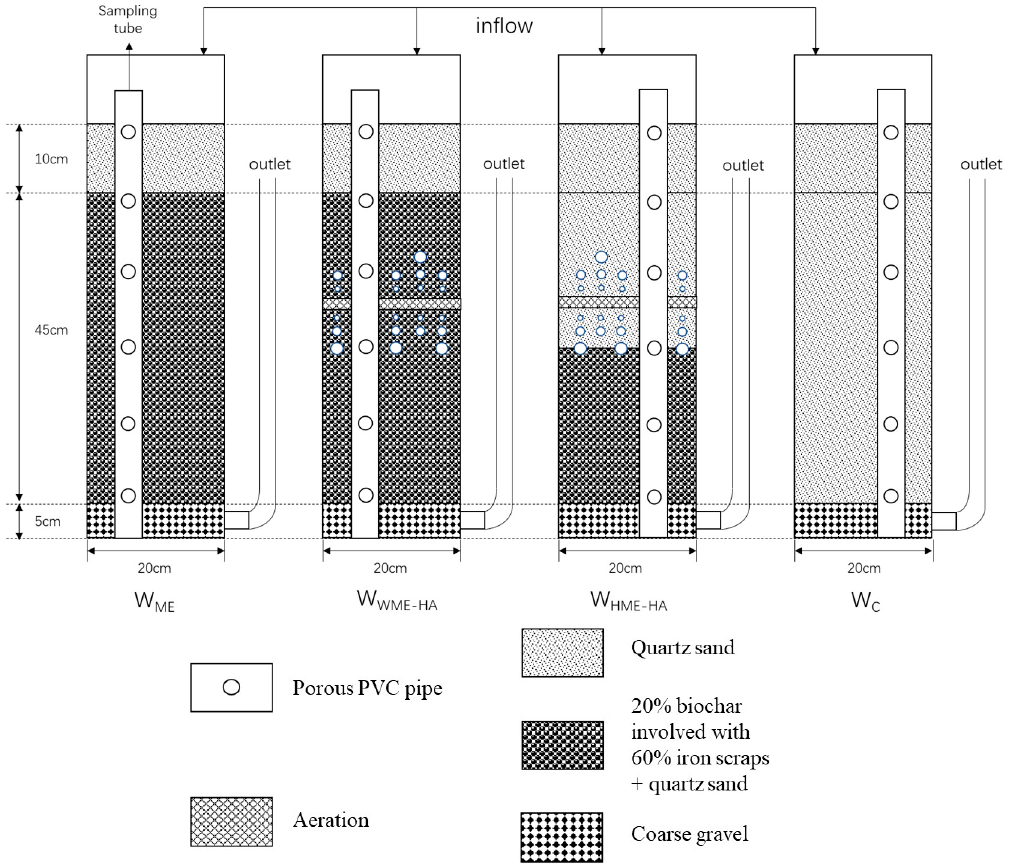
Figure 1. Schematic diagram of experimental laboratory-scale subsurface flow constructed wetlands (SSFCW).